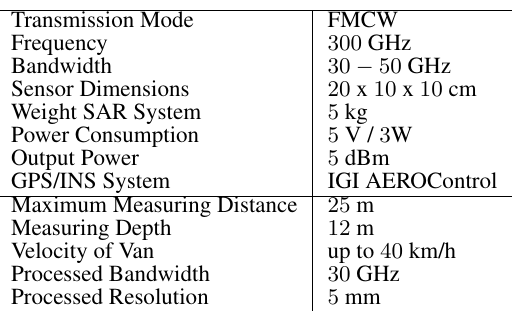
Table 1. Carborne sensor and processing parameters